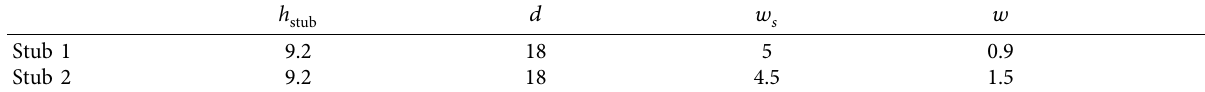
Table 1: Parameters of the two stubs (unit: mm).